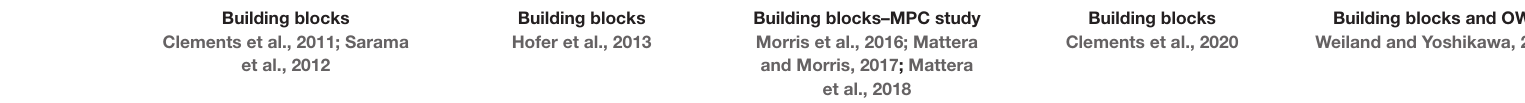
TABLE 8 | The pattern of effects on teacher and child outcomes across cognitive skills